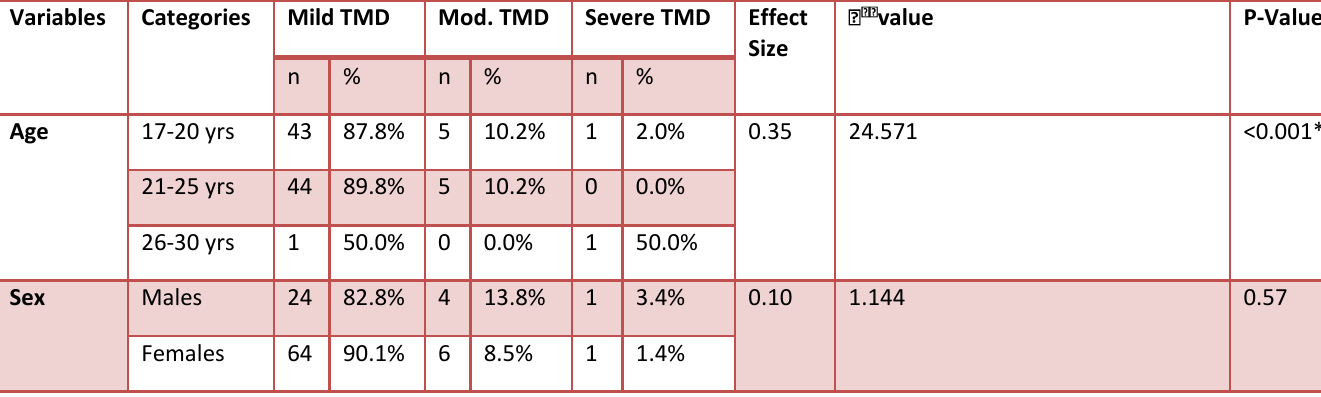
Table 5 - Age and gender wise comparison of distribution of varying grades of TMD among study